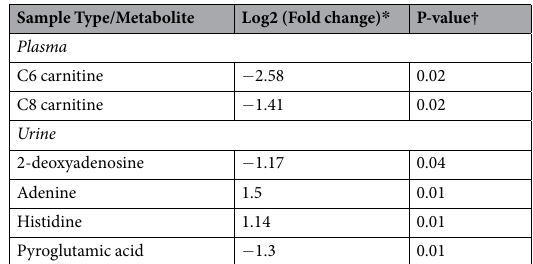
Table 1. Metabolites with differential concentrations by Hhip genotype (Hhip + / − versus Hhip + / + ) in room air-exposed mice. * Negative values indicate lower concentration in Hhip + / − heterozygotes (minimum 2x fold change). † Student’s t-test. No metabolites met the thresholds for significance in lung